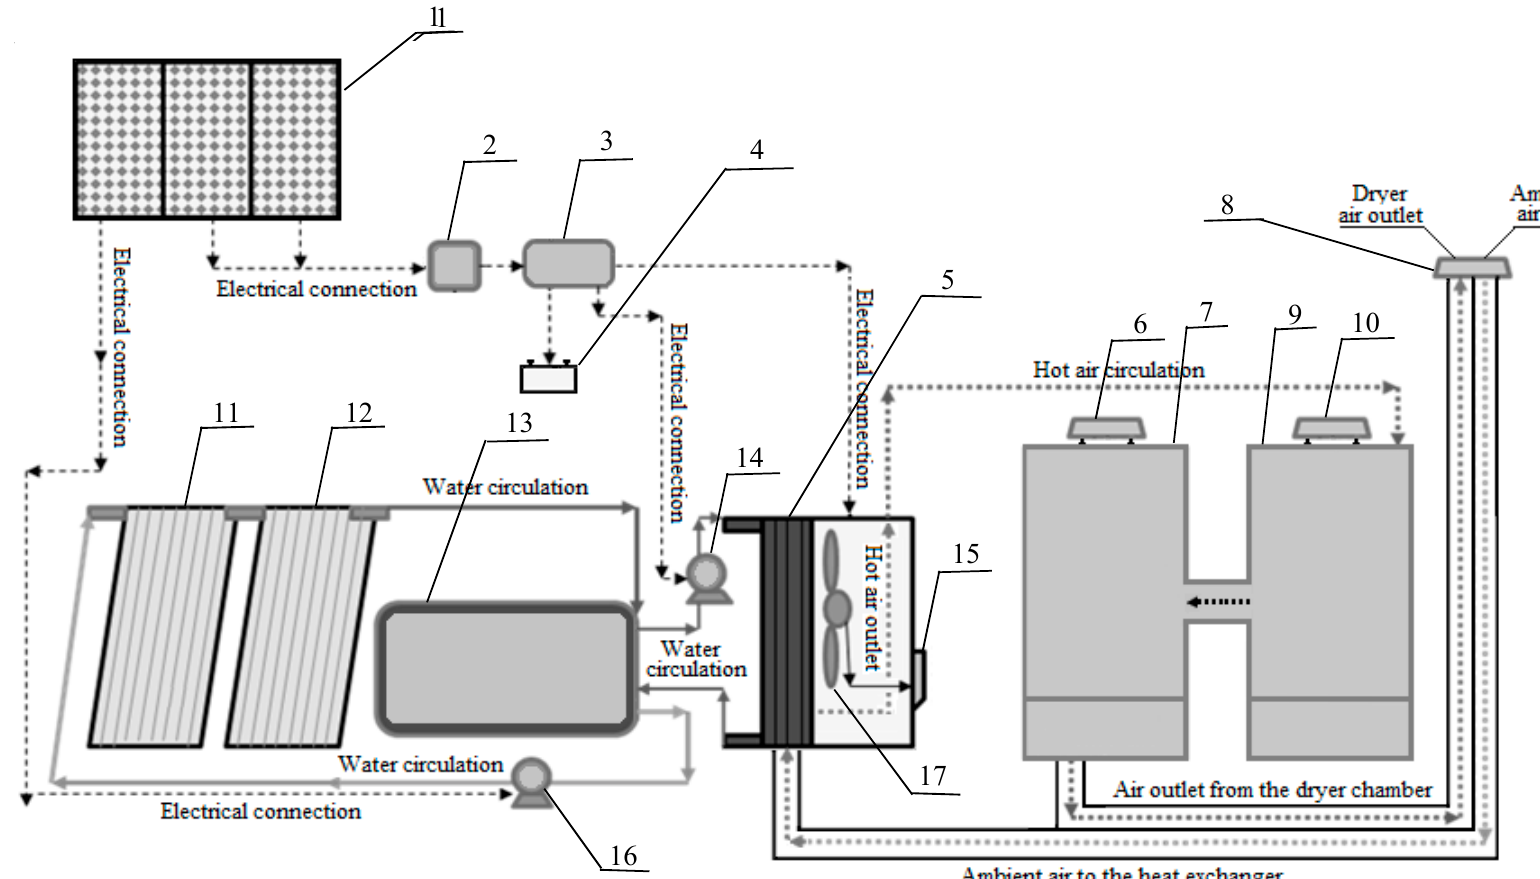
Figure 1. Schematic representation of the indirect solar dryer assisted with photovoltaic cells and with the thermal energy storage unit. (1) Three photovoltaic cells, (2) voltage controller, (3) electrical switches board, (4) battery, (5) heat exchanger air-water, (6) digital balance, (7) drying chamber # 2, (8) window for entry and exit of air dryer, (9) drying chamber # 1; (10) digital balance, (11) (12) solar collectors for water (U-pipe), (13) hydro-pneumatic tank water with inner membrane for thermal energy storage (with external insulation), (14) water pump, (15) variable speed drive for airflow, (16) water pump, (17) variable speed fan.